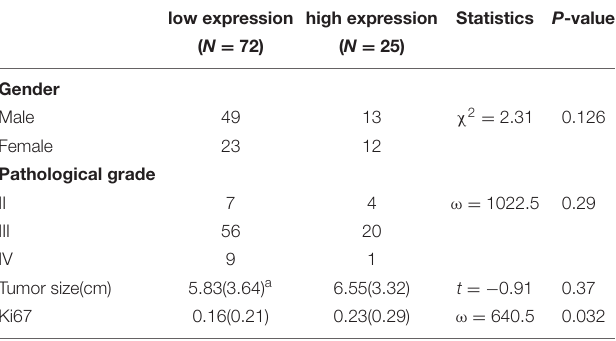
TABLE 2 | Distribution of each factor for S100A16A high and S100A16 low groups.